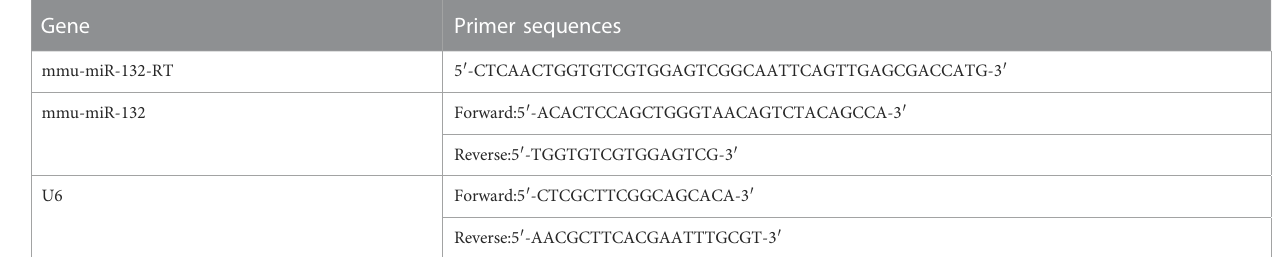
TABLE 1 The primers used for PCR. Gene Primer